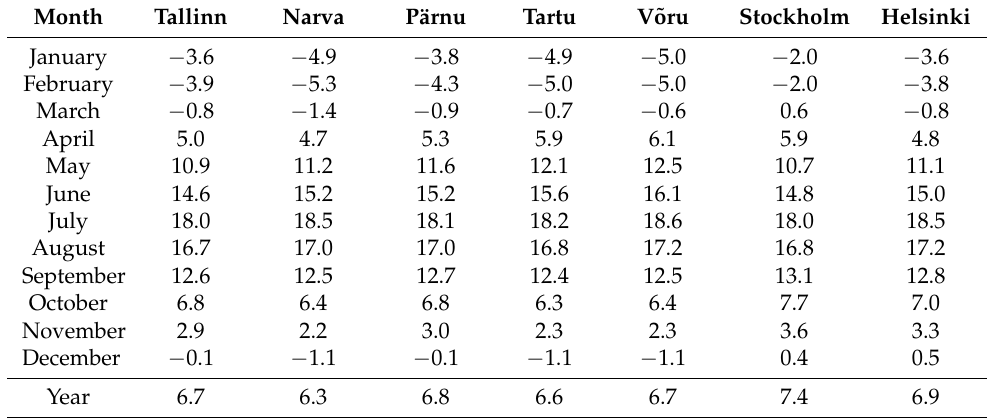
Table 5. Average monthly and annual surface air temperatures ( ◦ C) during the period 2005–2019. Month Tallinn Narva Pärnu Tartu V õ ru Stockholm